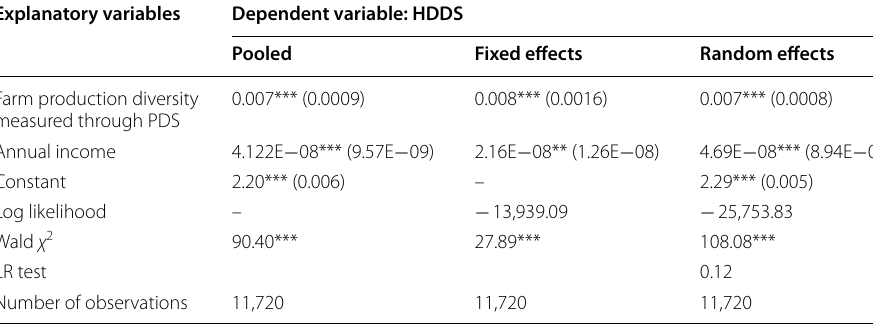
Authors’ analyses using 3 rounds of BIHS panel data ***, and ** indicate significance at the 1% and 5%, levels, respectively; figures in the parentheses indicate standard